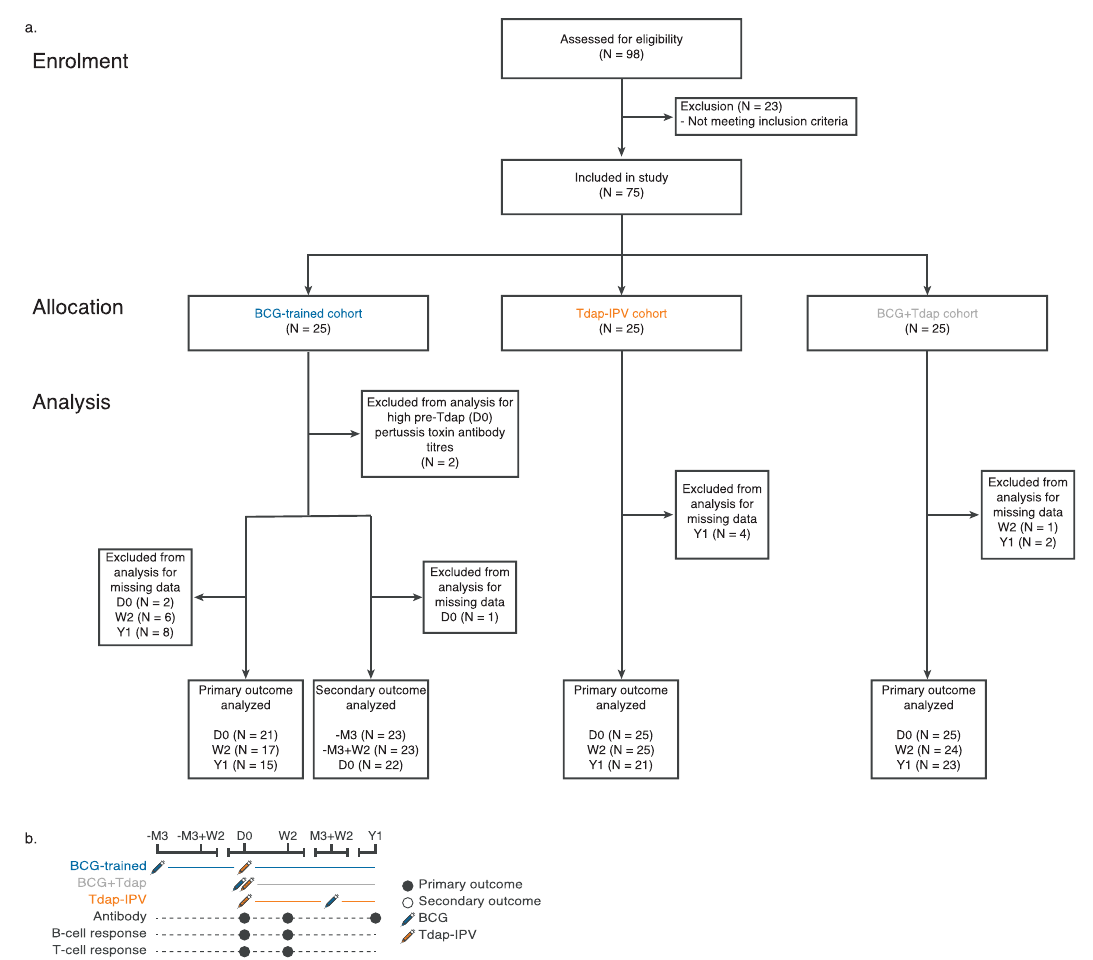
Fig. 1 Flow diagram and study procedures. a Flow diagram of subjects who were enrolled in the study and analyzed. Seventy- fi ve female subjects were randomly assigned to one of three study cohorts. b Overview of the study design and measurements. Antibody, B-cell and T-cell responses were measured across all three cohorts (primary outcomes, black circles). Ex vivo peripheral blood mononuclear cell cytokine production in response to heterologous stimulation with heat-killed microbes or microbial ligands was measured in the BCG-trained cohort (secondary outcomes, white circles). Timestamps are de fi ned relative to the baseline of Tdap-IPV vaccination (-M3 = 3 months prior, -M3 + W2 = 3 months prior plus 2 weeks, D0 baseline of Tdap-IPV or concurrent Tdap-IPV and BCG vaccinations, W2 2 weeks thereafter, M3 + W2 3 months plus 2 weeks thereafter, Y1 1 year